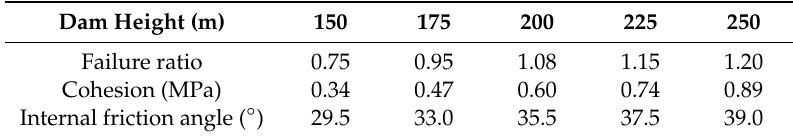
YSFCS with di ff erent dam